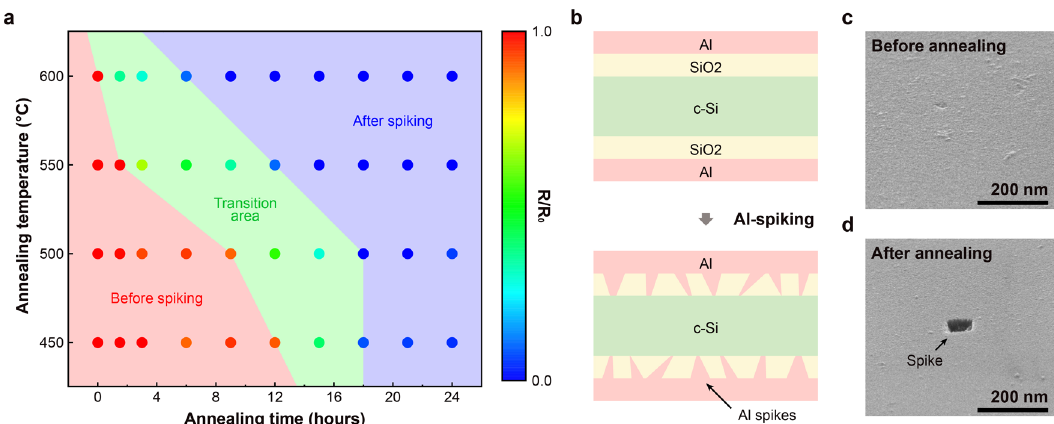
Fig. 2 Resistance changes after Al spiking. a Electrical resistance of Al/SiO 2 /Si/SiO 2 /Al structure as a function of annealing temperature and duration. b Schematic illustration of sample structure evolution upon annealing to induce thin- fi lm reaction between Al and SiO 2 to form Al “ spikes ” penetrating the SiO 2 layers. c , d Scanning electron micrographs of SiO 2 surface, before and after annealing. e Scanning electron micrographs of SiO 2 surface before annealing and after 24 h annealing at temperatures of 450 – 600 °C.